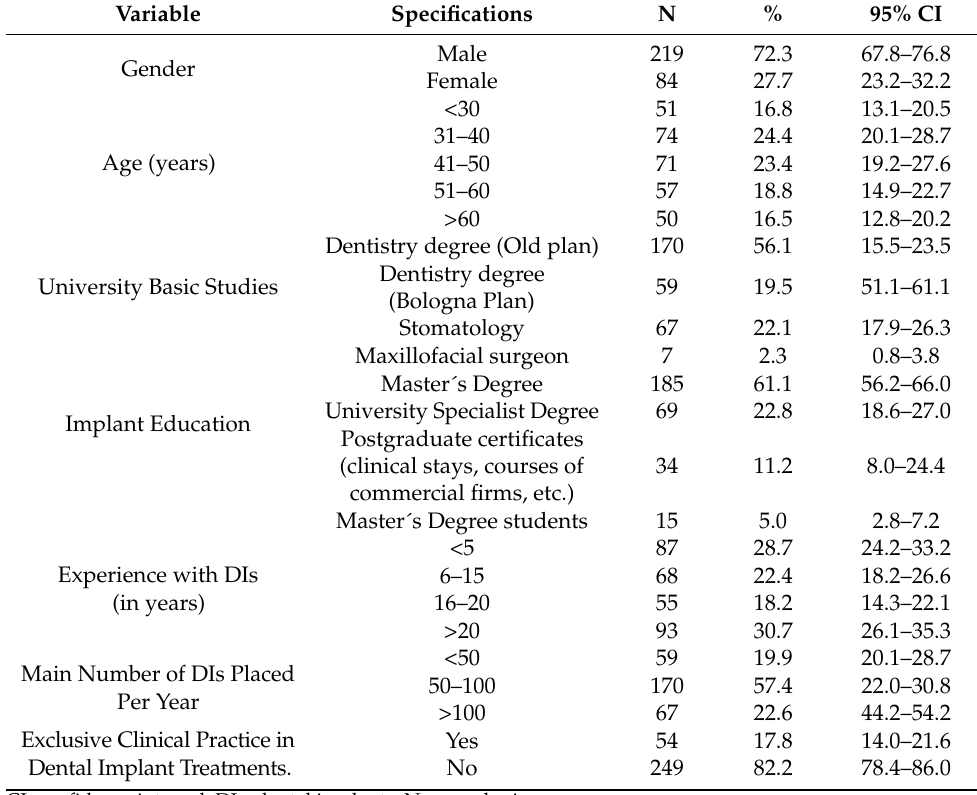
Table 1. Demographic and professional characteristics of the study